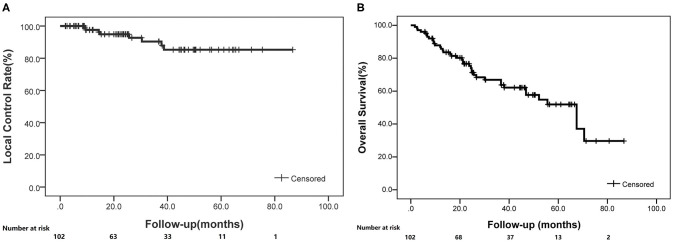
The local control and overall survival rates for enrolled patients treated with SBRT (K-M curve). (A) Local control rates through follow-up. (B) Overall survival rates through follow-up.